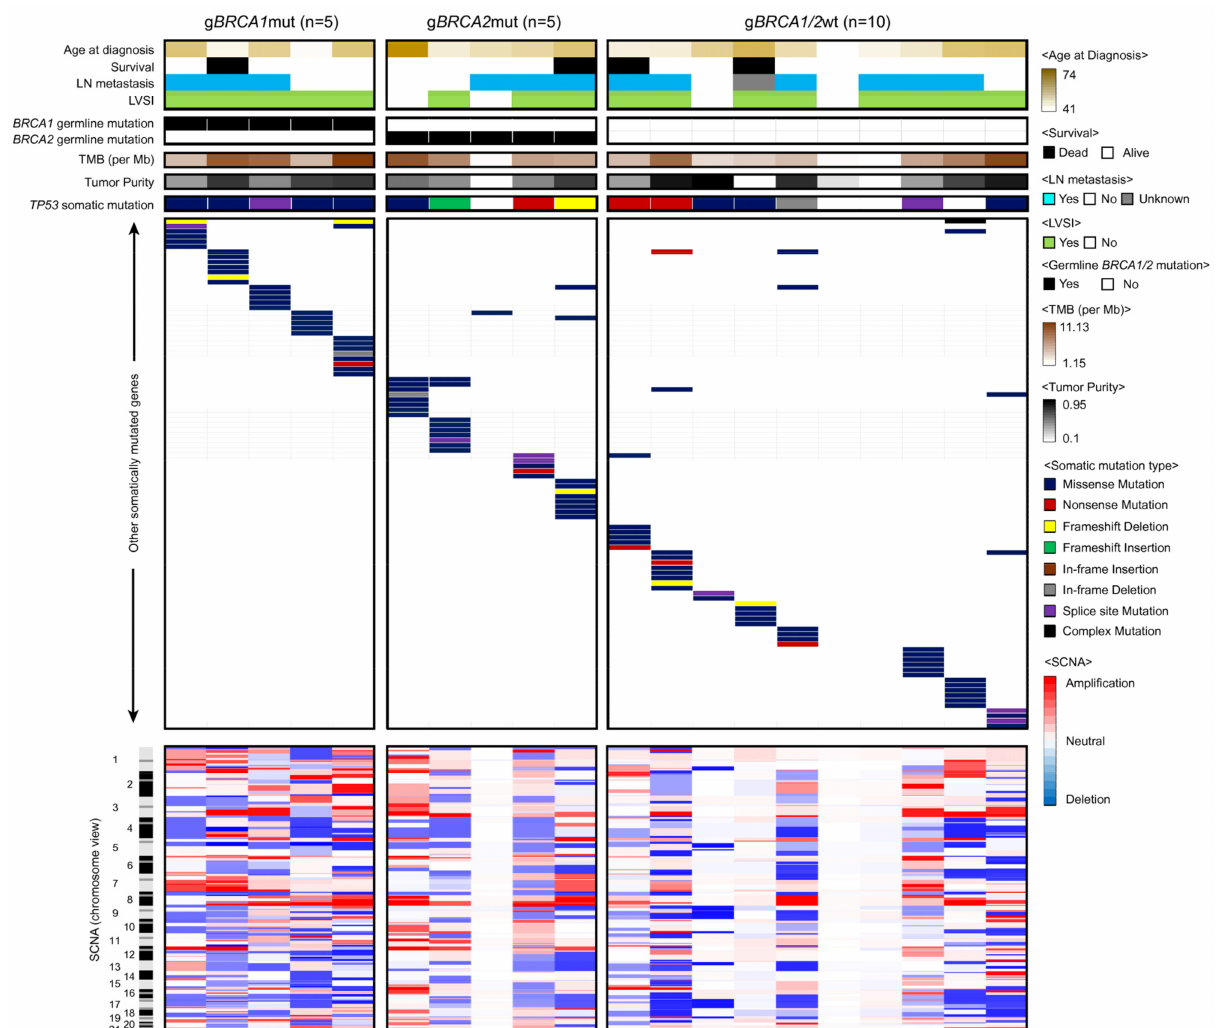
Figure 2. Genomic mutational characterization of 20 HGSOC samples. The distribution of somatic mutations among three categories of samples. Each column displayed here represents an individual case. LN, LVSI, TMB, and SCNA stand for lymph node, lymphovascular space invasion, tumor mutational burden, and somatic copy number alteration,